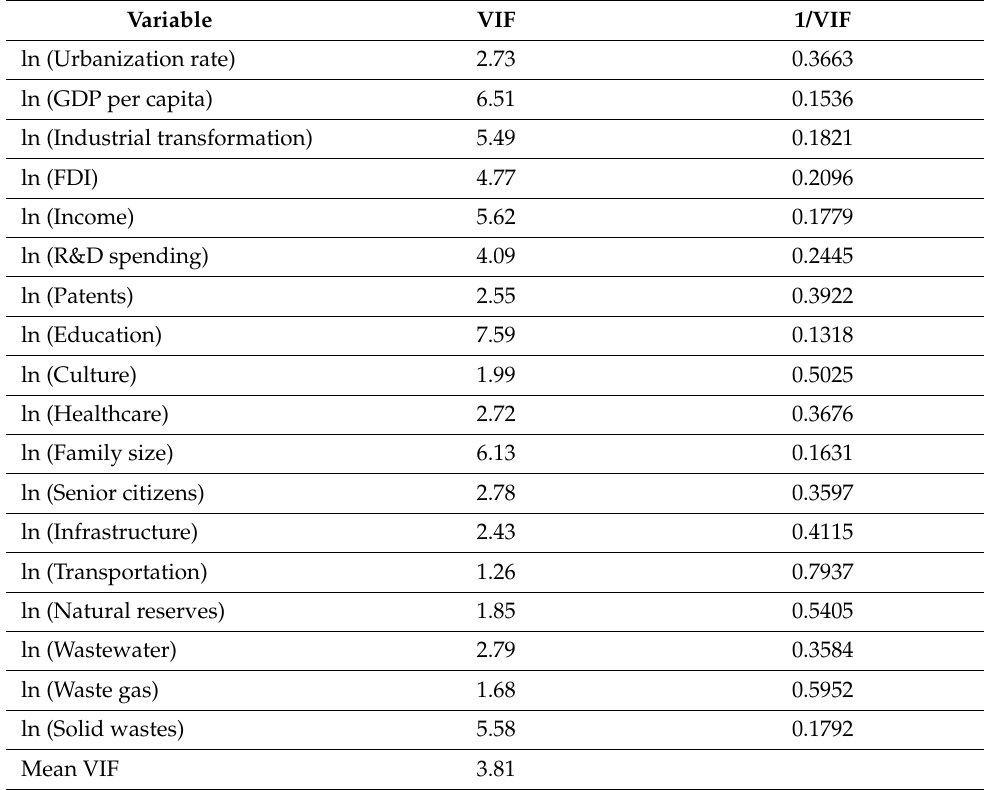
Table 3. Variation inflation factor (VIF)